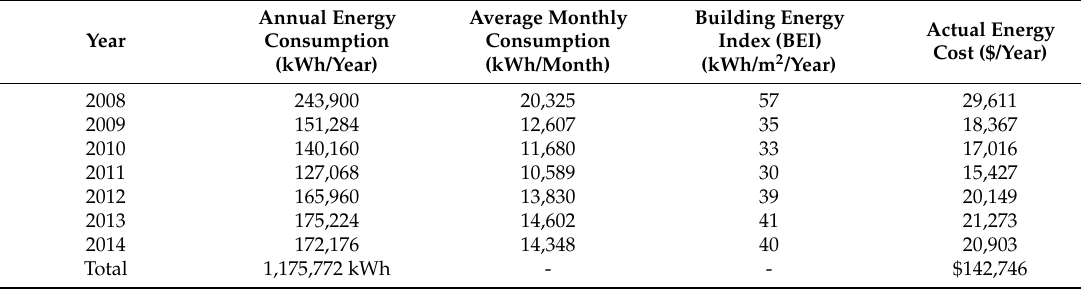
Table 2. Actual energy consumption and cost